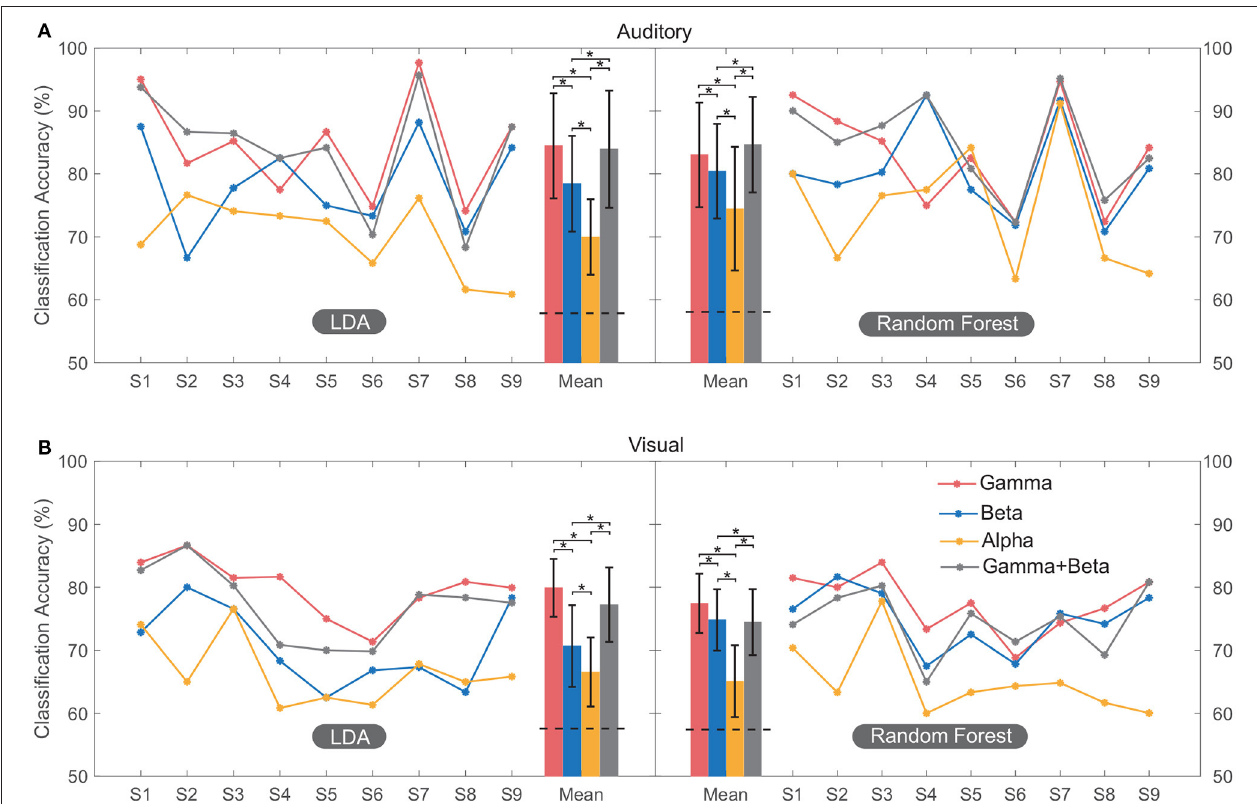
FIGURE 4 | Classification performance of multi-region contacts for all the subjects. The accuracy of each subject was plotted by line graph, and their mean value was plotted by bar graph for convenient observation. In both auditory (A) and visual (B) modalities, classification was conducted using LDA and random forest. Error bars depict the standard deviation of the classification accuracies across subjects. The “*” indicates the significant difference. The horizontal black dashed line on the bars of mean accuracy indicates the mean significance level of classification (section 2.6.2) using high-gamma band across